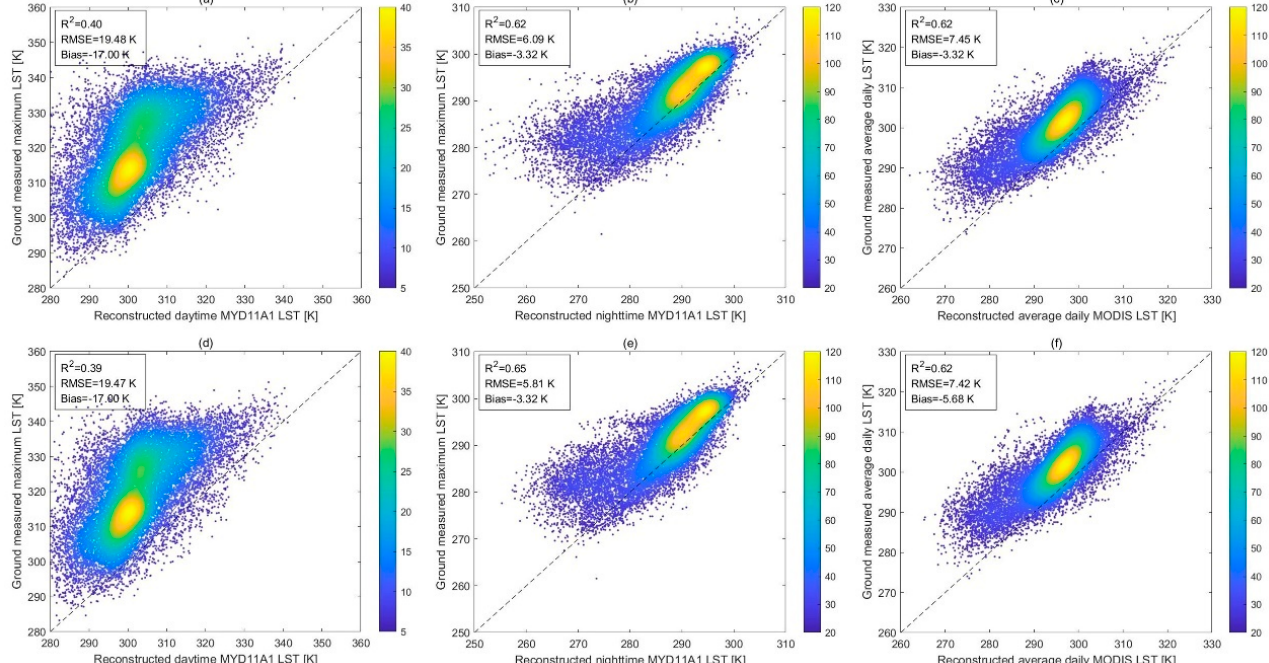
Figure 8. Validation results for reconstructed ( a ) MYDLSTD_Rec; ( b ) MYDLSTN_Rec_SG; ( c ) MODLSTAvg_Rec; ( d ) MYDLSTD_Rec_SG; ( e ) MYDLSTN_Rec_SG, and ( f ) MODLSTAvg_Rec_SG using CMA LST data from June to August 2017. Color bar represents the counts of the points falling in each square.